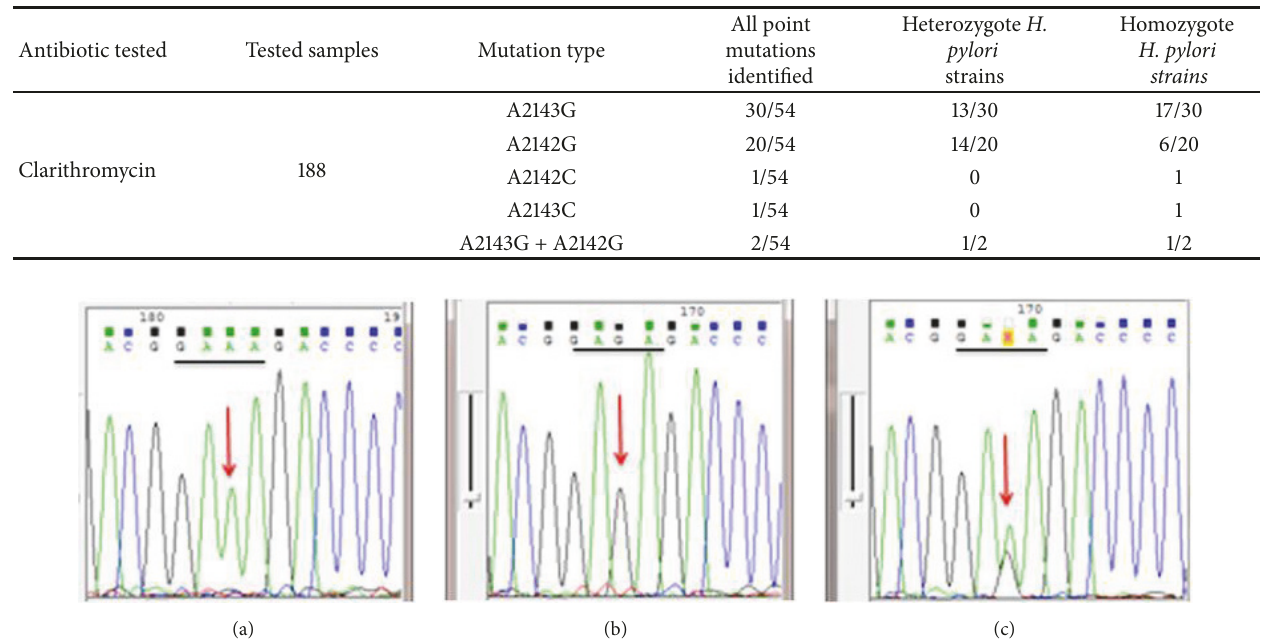
Table 1: Patterns of mutations among 54 patients/samples with point mutations.